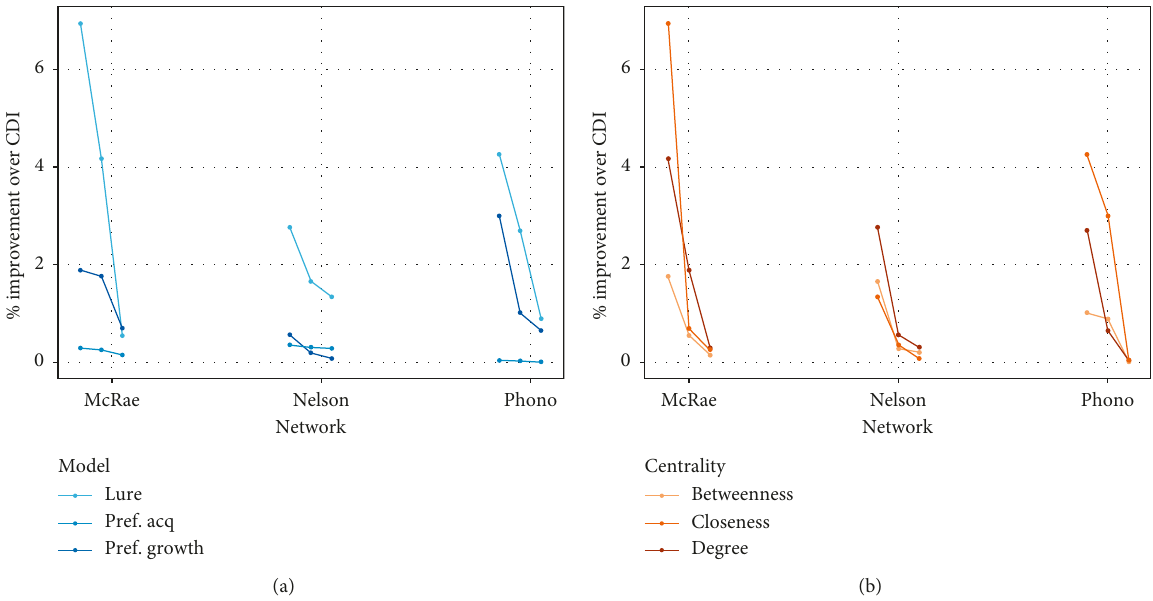
Figure 5: Percent improvement in log-likelihood of predictions on validation as compared to CDI baseline model. Performance is clustered by growth mechanism (a) or centrality (b). Positive y -values indicate improvement over the CDI baseline model; position along the x -axis is for better legibility and not reflective of performance across